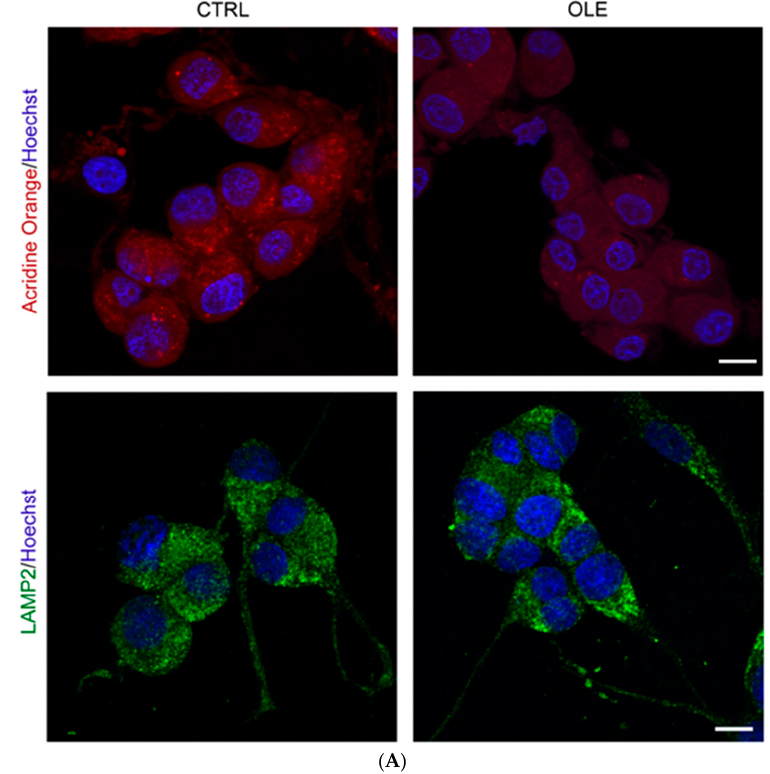
Figure 6. Cont. Figure 6.